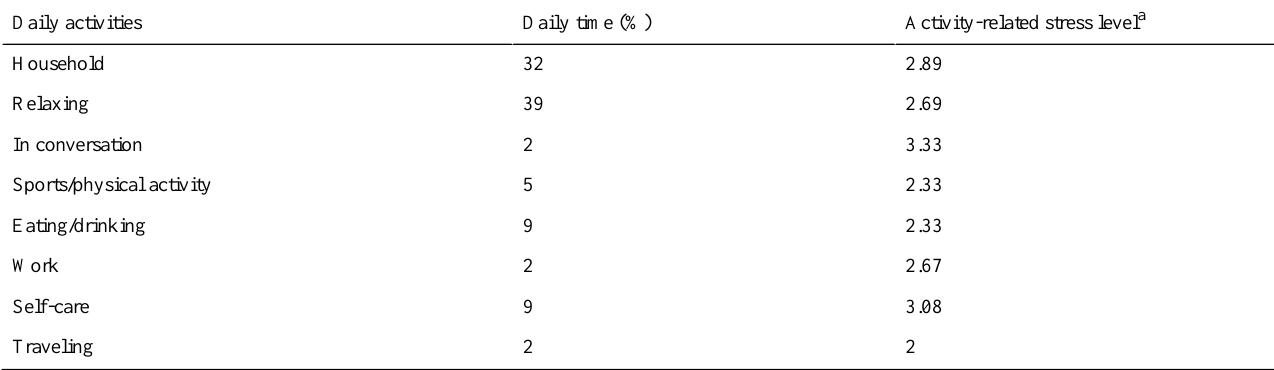
Table 5. Person 2: daily activities and levels of activity-related stress.